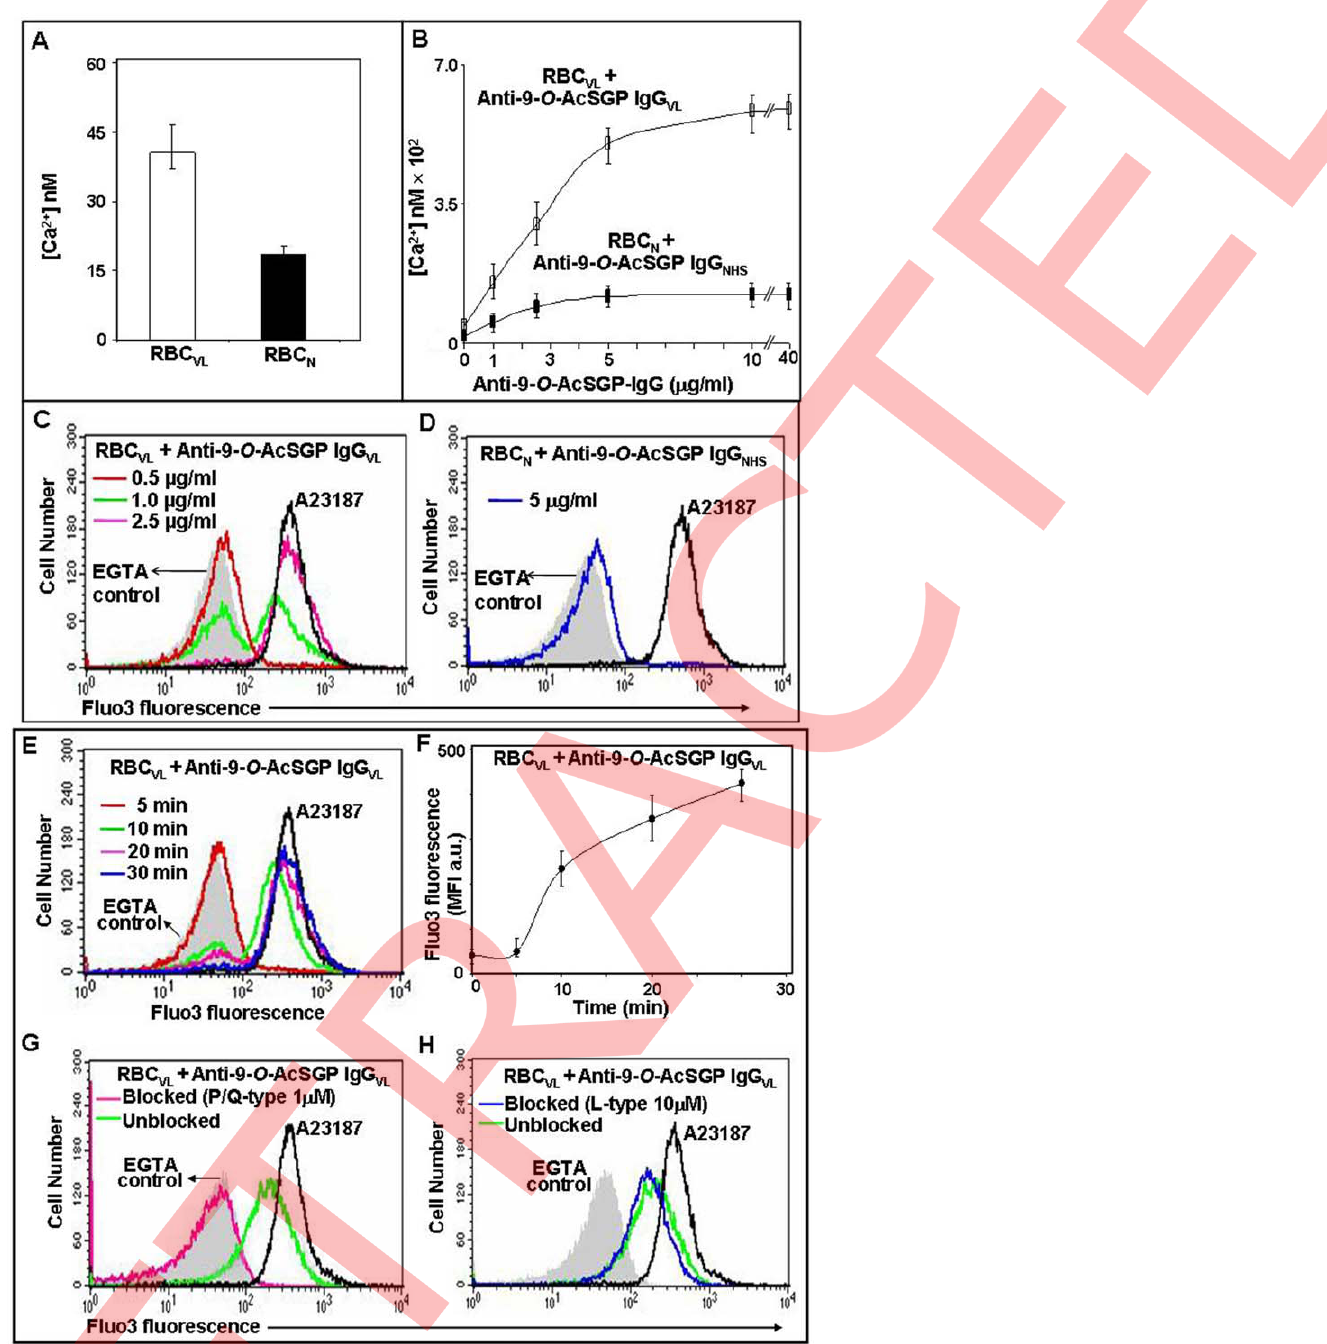
Figure 3. Calcium influx into RBC upon sensitization with anti-9- O -AcSGP IgG VL antibodies. For all experiments, erythrocytes were washed and loaded with the Ca 2 + -indicator fluorochrome Fluo-3/AM in Ringer solution. A23187-treated Fluo-3/AM-loaded RBC VL served as positive controls (black line) and A23187-treated cells in the presence of EGTA as negative controls (gray background). A. Fluo-3/AM loaded RBC VL and RBC N (2 6 10 7 ) were left unsensitized or sensitized with varying concentrations of anti-9- O -AcSGP IgG VL or anti-9- O -AcSGP IgG NHS , respectively, (0–40 m g/ml) in Ringer solution for 30 min at 37 u C. After washing the cells twice with same solution the fluorescence intensities of the Ca 2 + -Fluo-3 complexes was determined by spectrofluorimetry and the levels of intracellular calcium calculated as described in Materials and Methods. B. Cells treated as in A with 0.5 m g/ml (red line), 1.0 m g/ml (green line) and 2.5 m g/ml (pink line) anti-9- O -AcSGP IgG VL were analyzed by flow cytometry to determine the fraction of responding RBC. C. Similarly, RBC N were analyzed without and with sensitization with 5 m g/ml anti-9-O-AcSGP IgG NHS (blue line). D–E. Time dependent increase of intracellular Ca 2 + in RBC VL after sensitization with anti-9- O -AcSGP IgG VL (2.5 m g/ml) for 5 min (red line), 10 min (green line), 20 min (pink line) and 30 min (blue line) at 37 u C. Cells were washed and analyzed by flow cytometry. D. Histogram representation; E. Mean fluorescence intensities calculated from D. F–G. Inhibition of the Ca 2 + influx into RBC sensitized with anti-9- O -AcSGP IgG VL . Prior to sensitization with anti-9- O -AcSGP-IgG VL (2.5 m g/ml), the cells were incubated without (green line) or with the P/Q-type channel blocker v -agatoxin TK (1 m M, pink line, F ), or without (green line) or with the L-type channel blocker nifedipine (10 m M, blue line, G ) and analyzed by flow cytometry.